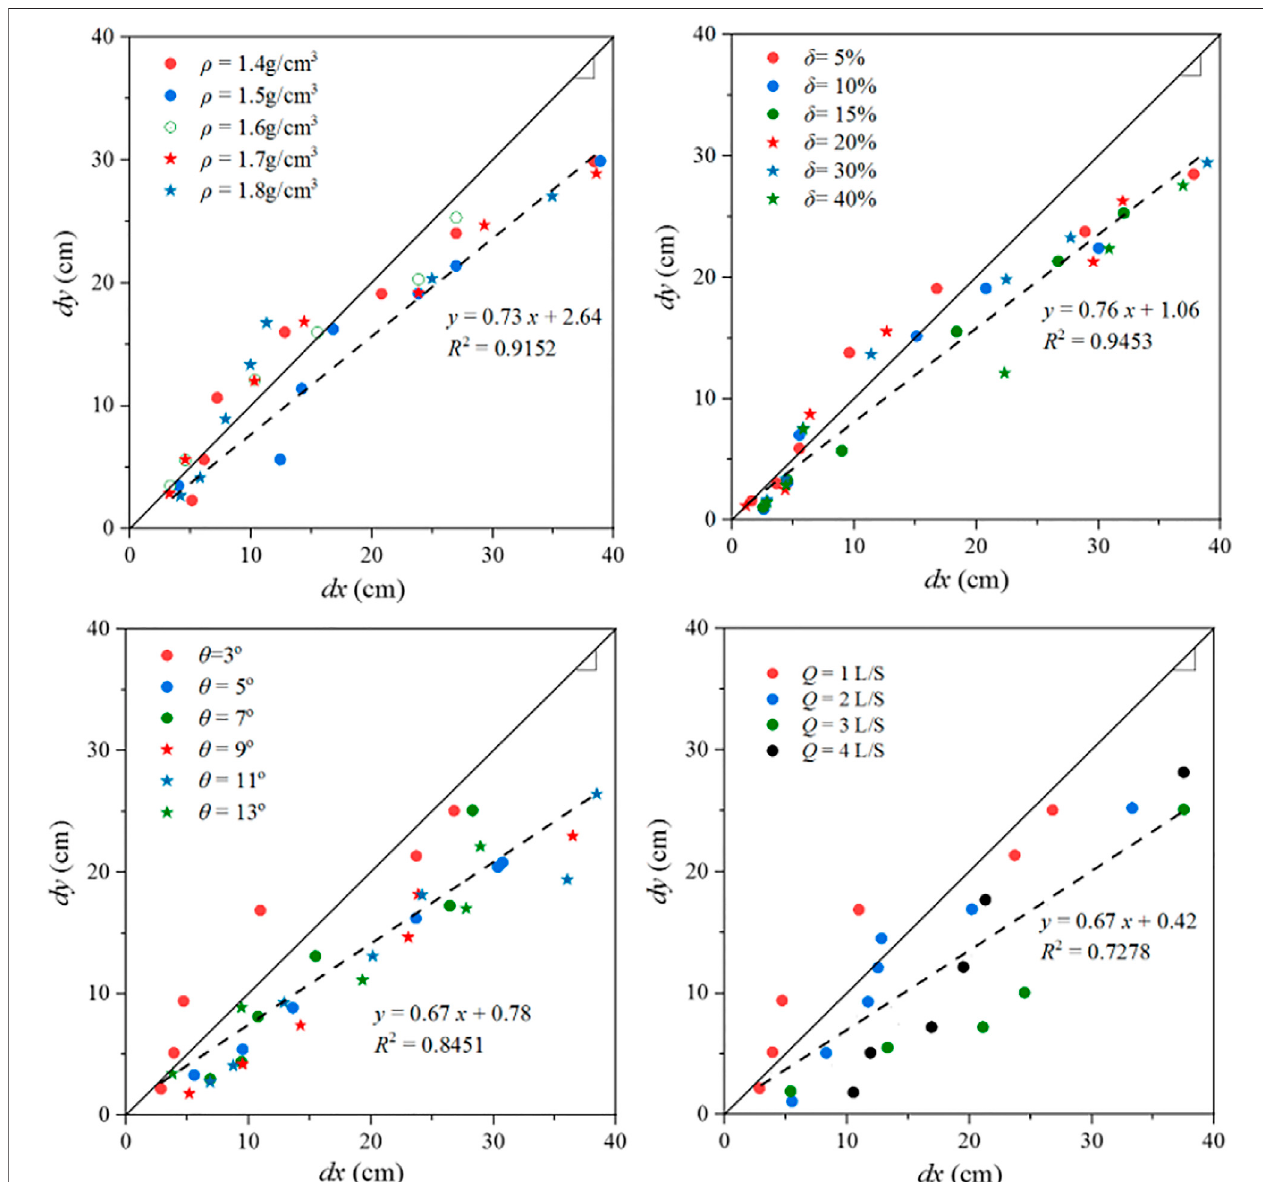
FIGURE 5 | Linear positive correlation relationships between dx/dt and dy/dt under different in fl uencing factors ( ρ : bulk density, δ : fi ne particle content, θ : channel slope, and Q : upstream water discharge).